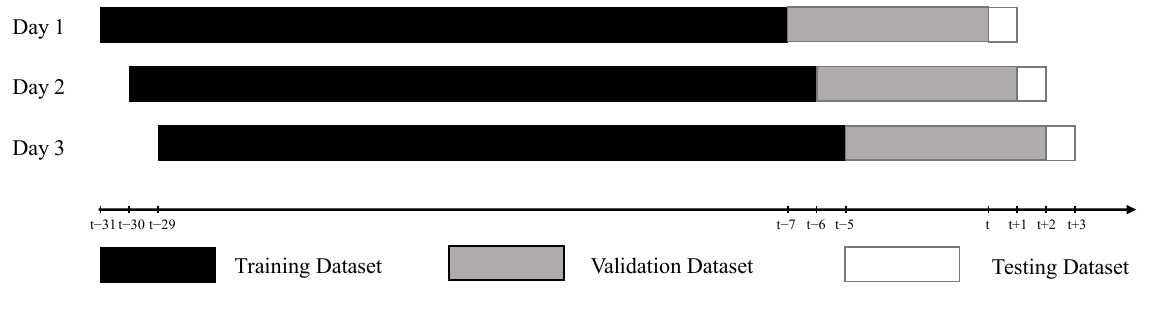
Figure 3. Walk-forward